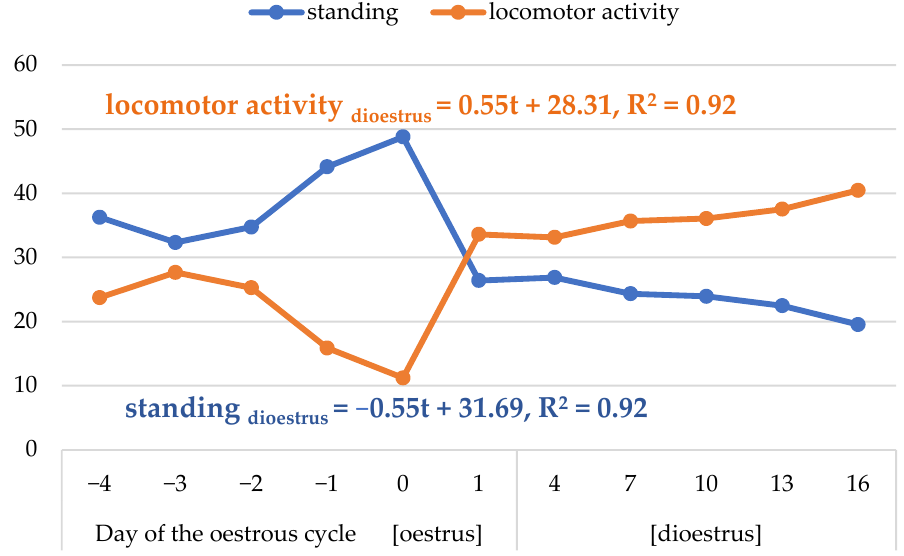
Figure 6. Dynamics of changes in the average time of standing and locomotor activity (s) in the morning during the oestrous cycle and regression models for dioestrus.